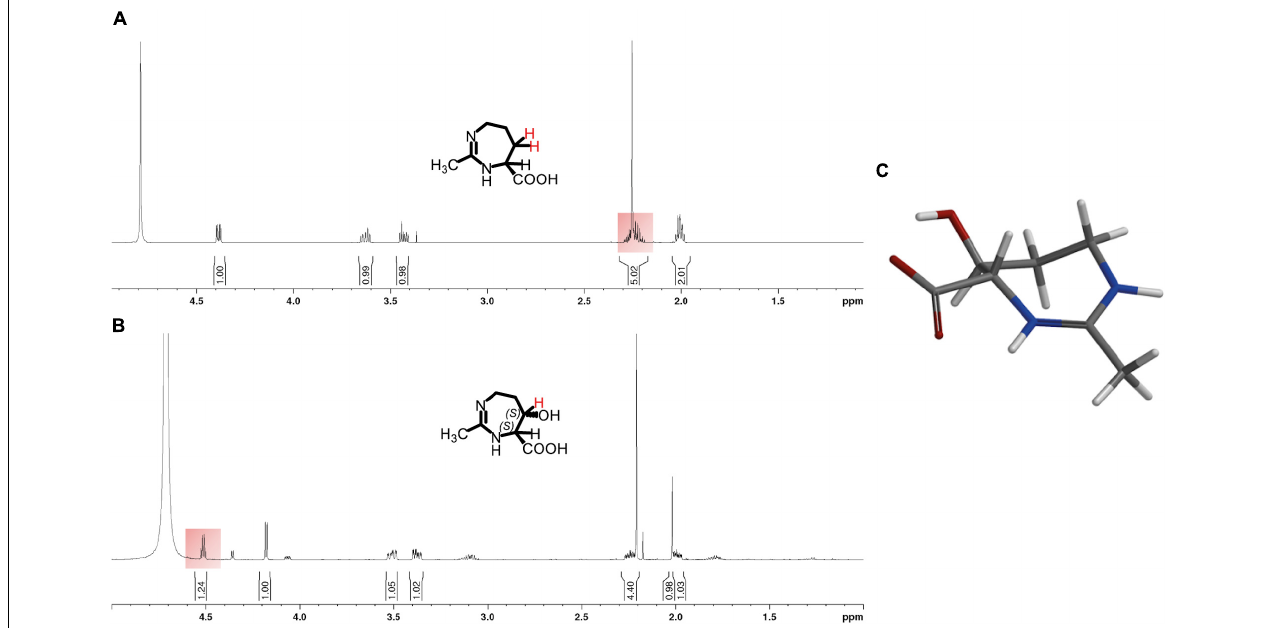
FIGURE 6 | 1 H-NMR spectra of (A) homoectoine and (B) 5-hydroxyhomoectoine. The changing 1 H-signal is highlighted in red. (C) DFT calculated structure of 5-hydroxyhomoectoine. Additional information and the recorded NMR spectra can be found in the Supplementary Material .